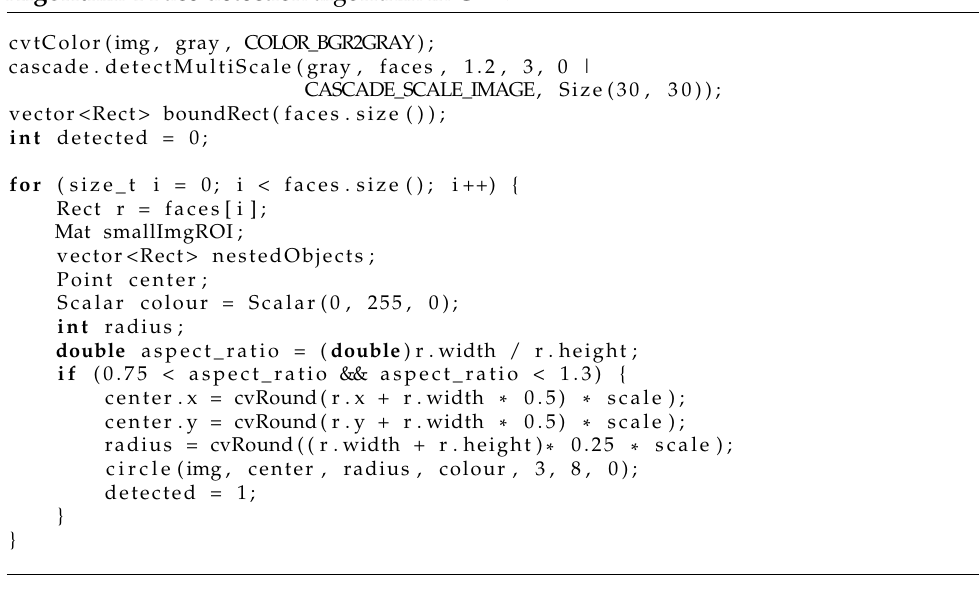
Algorithm 4 Face detection algorithm in C++.